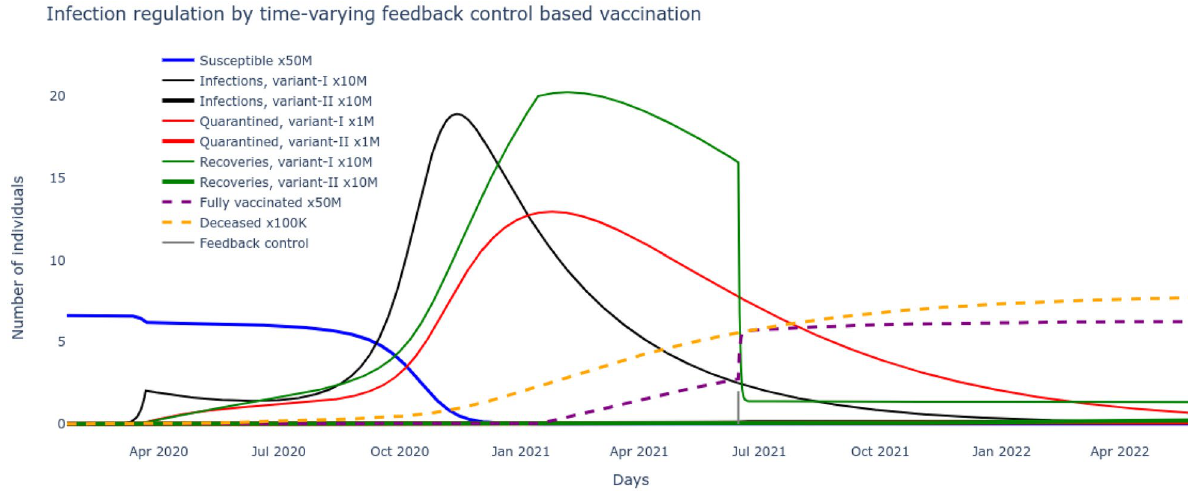
Figure 7. Eliminating the delta wave by time-varying feedback control based vaccination.